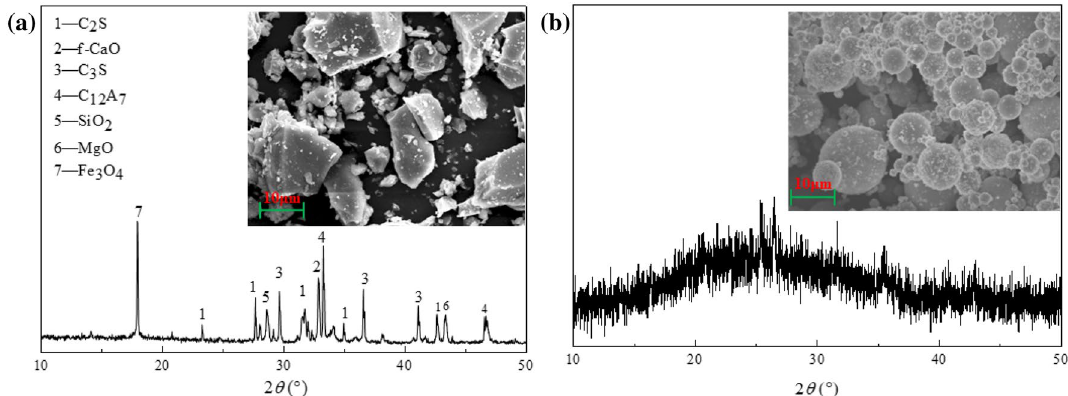
Figure 1. XRD and SEM imagines of the raw LFS ( a ) and raw FA ( b ); C 3 S: Ca 3 SiO 5 , C 12 A 7 : 12CaO ∙ 7Al 2 O 3